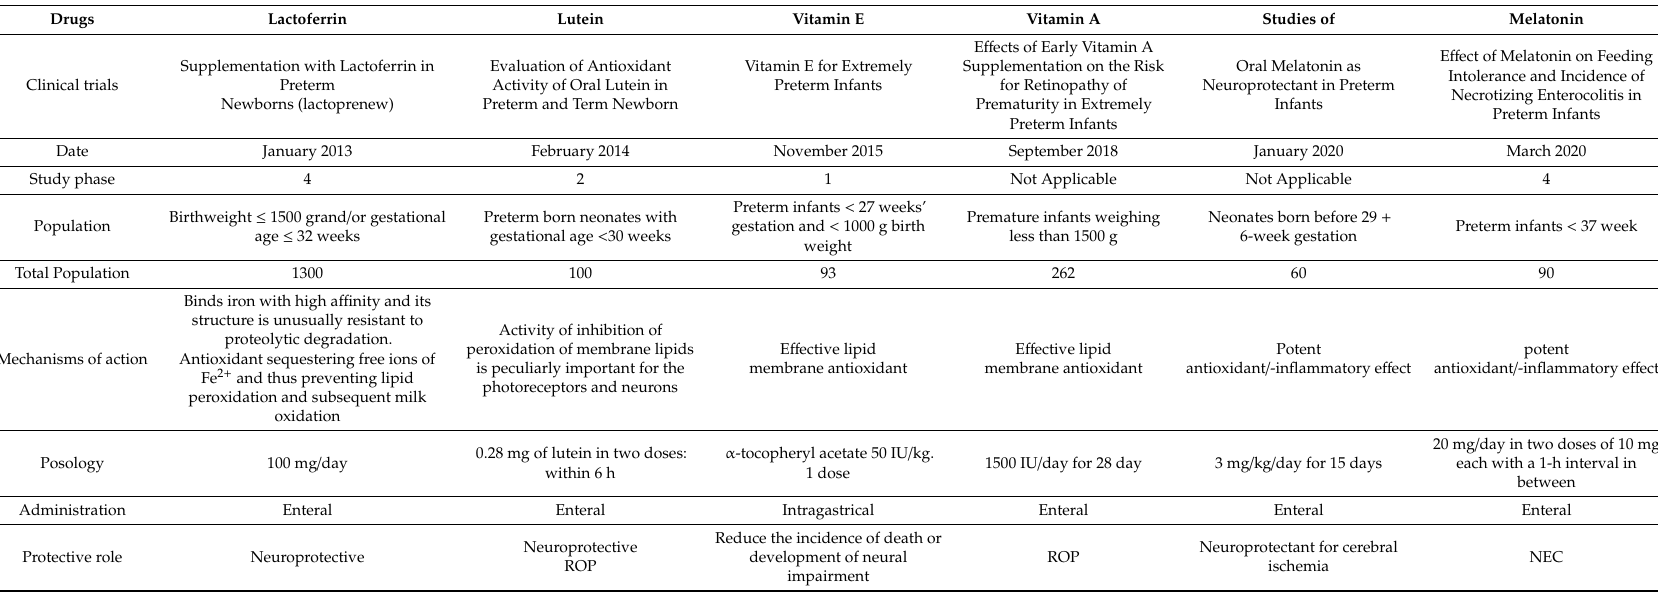
Table 3. Clinical studies on drugs that prevent oxidative stress in